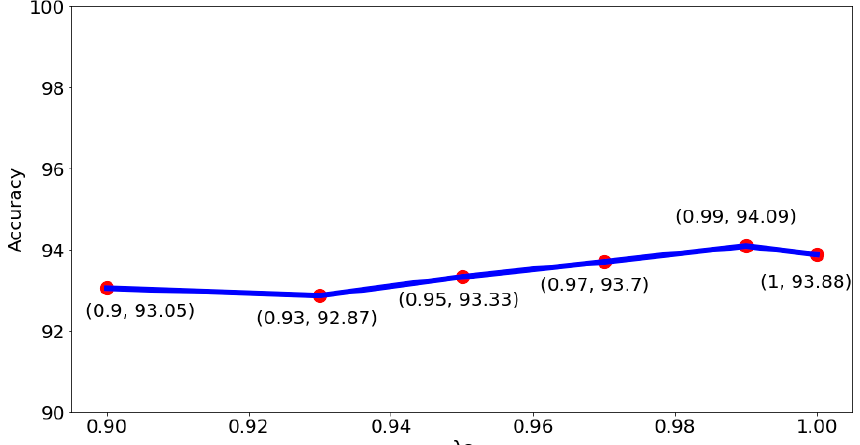
Figure 11. The impact of choosing different λ c on accuracy for binary classification.